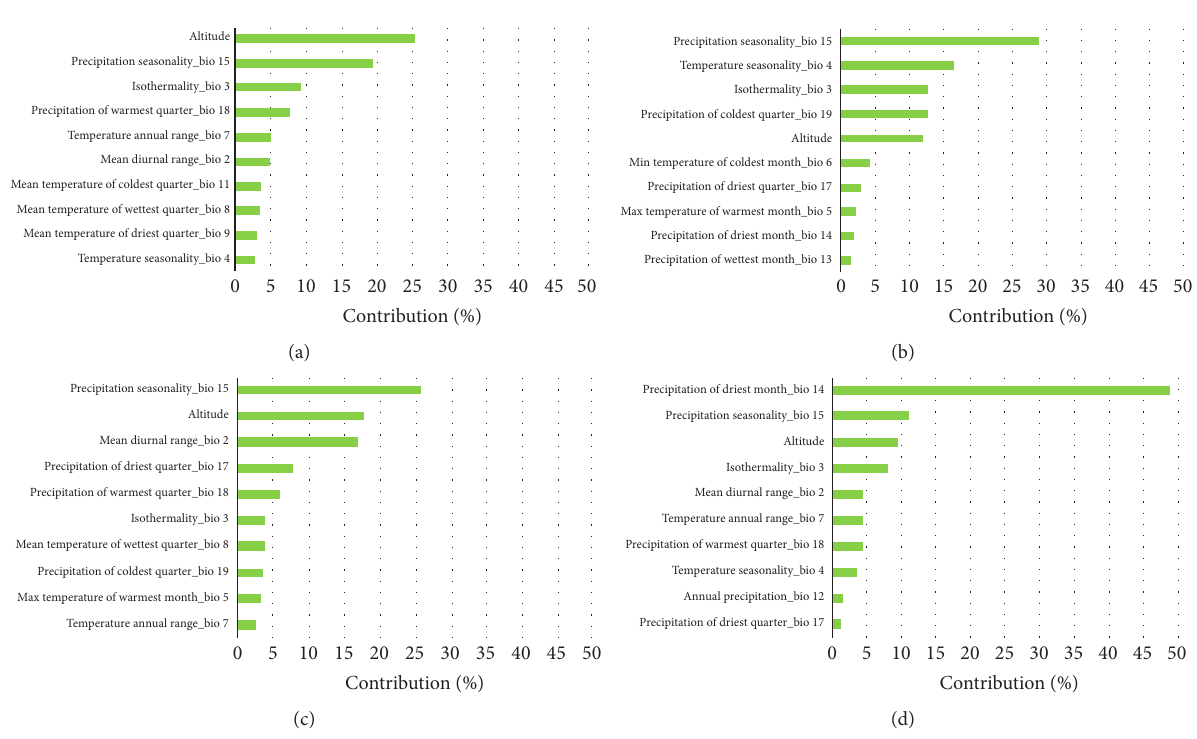
Figure2:VariationinTriatominaespeciesexplainedbyvariationofenvironmentalvariables,MethodJackknife:(a) Panstrongylusgeniculatus ; (b) Rhodnius pallescens ; (c) Rhodnius prolixus ; (d) Triatoma